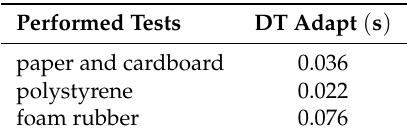
Table 3. Collision Detection Times (DT) for the three different materials using the adaptive virtual sensor.